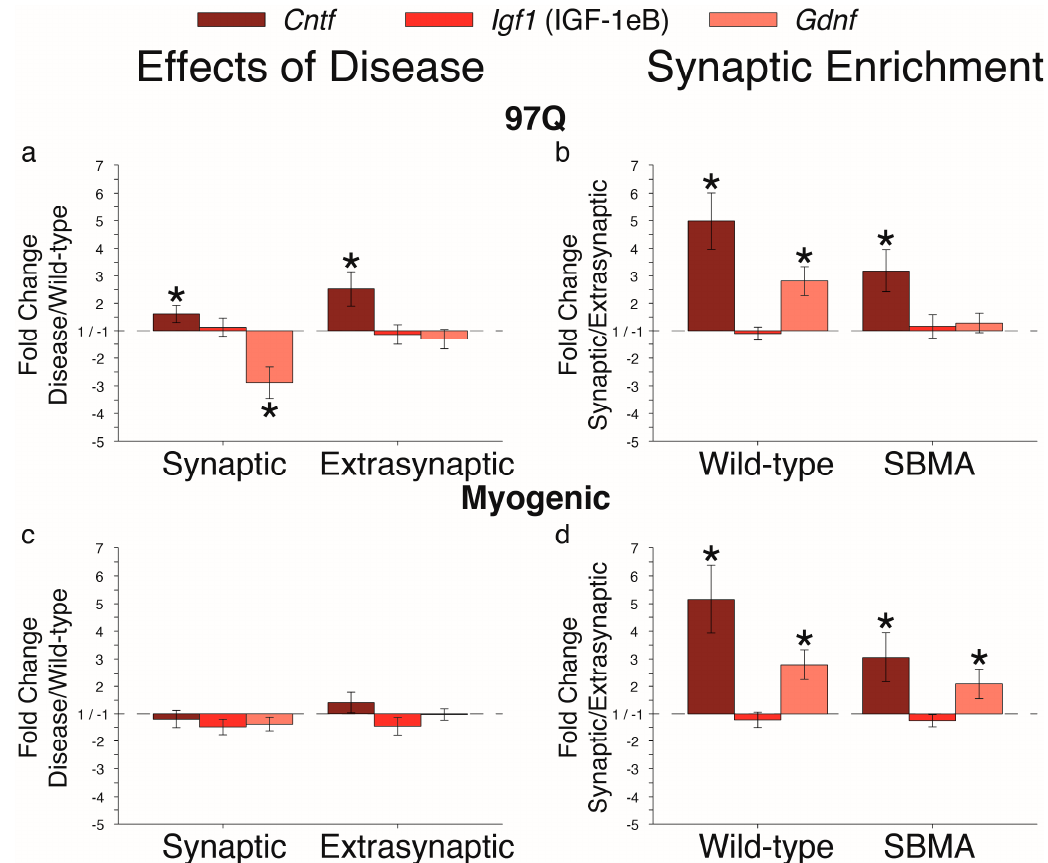
Figure 4. Disease affects expression of neurotrophic factors Cntf and Gdnf, but not Igf1 (IGF-1eB variant). ( a , c ) Disease upregulated Cntf mRNA in muscle from 97Q but not myogenic mice. ( b , d ) Unlike the neurotrophins (Figure 2), expression of Cntf and Gdnf mRNA was enriched in the synaptic region of WT muscle, with disease having eliminated the synaptic enrichment of Gdnf in the 97Q model. Effects only in the 97Q model may reflect differences in the disease allele expressed (human disease allele AR in the 97Q model versus overexpression of WT rat AR in the myogenic model), and suggests that both Cntf and Gdnf may also contribute to neuromuscular dysfunction in SBMA patients. Fold changes ± SEM are relative to wild-type ( a , c ) or extrasynaptic ( b , d ) samples; Statistical analysis was based on pair ‐ wise fixed reallocation randomization test: * p < 0.05. We also examined other genes implicated in synaptic structure and function, including Musk , Lrp4 , Chrng , Rtn4 , Mmp9 , and Scn4a (Figure 5a,c,e). Musk mRNA was upregulated in both models, while the gene encoding its binding partner Lrp4 was upregulated in the 97Q model, but downregulated in the myogenic model. We also found that Rtn4 (encoding Nogo ‐ A, an inhibitory signal for axonal sprouting) transcripts were reduced in myogenic and 97Q mice, hinting at the muscle’s attempt to re ‐ establish strong synapses. Levels of Chrng mRNA , encoding AChR gamma subunit, were upregulated, but only in the 97Q model. Mmp9 mRNA levels were not affected in these two models. Scn4a encoding the adult isoform of the alpha subunit of the voltage ‐ gated sodium channel was significantly reduced in muscle from both 97Q and myogenic mice (Figure 5), confirming previous reports [14]. We found this reduction in both synaptic and extrasynaptic regions. Finally, disease eliminated a synaptic enrichment of Musk in muscle in both models, suggesting a possible mechanism leading to the dispersal of AChR (Figure 5b,d), which could account for previously reported fragmentation of endplates in diseased muscles [29].